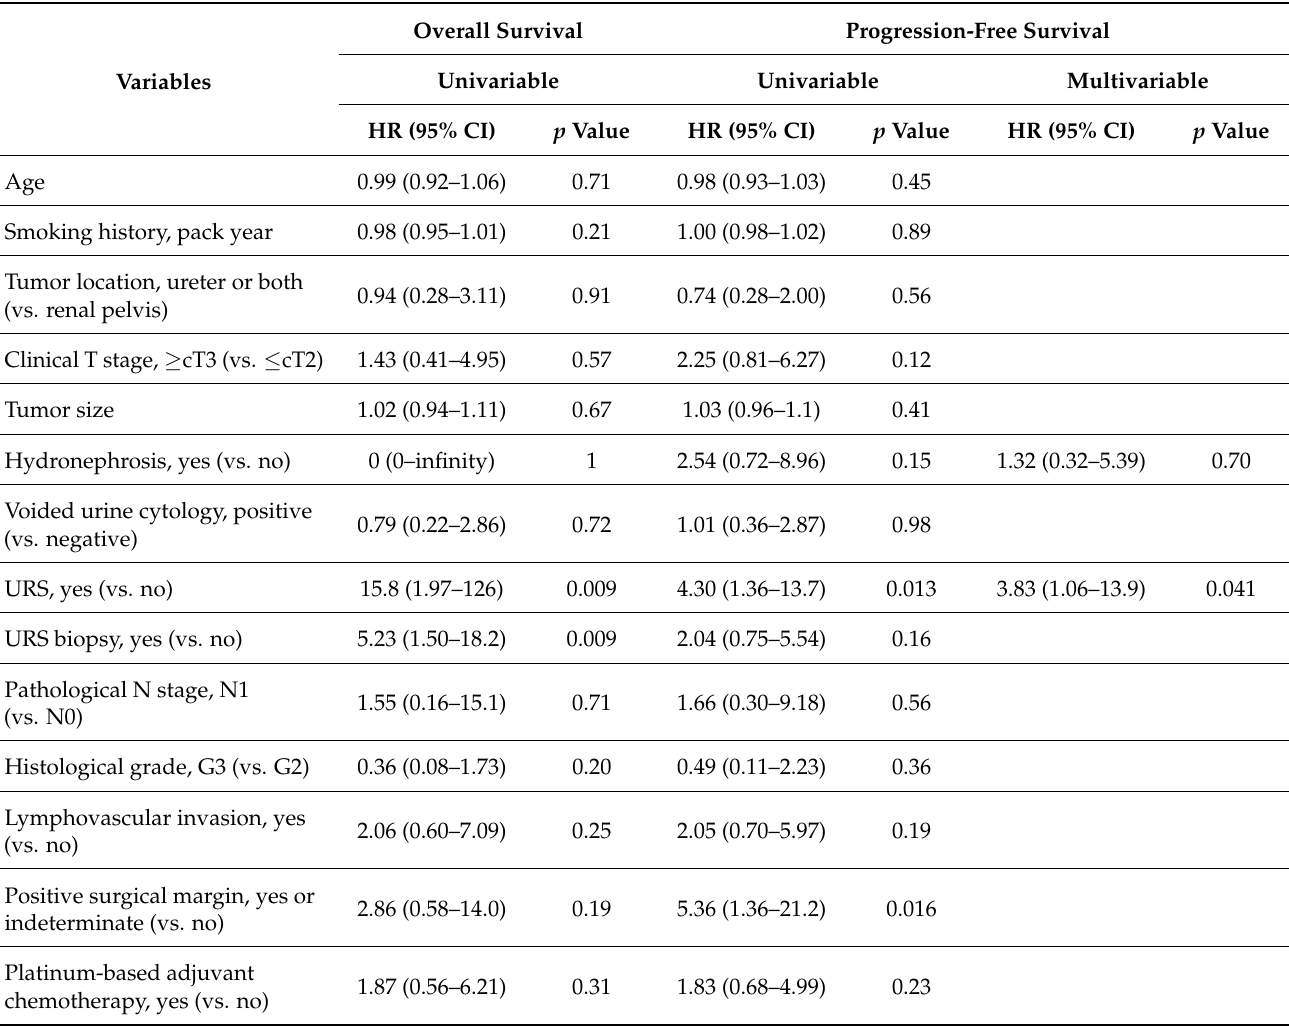
Table 5. Variables associated with overall and progression-free survival in the subgroup of non- papillary architecture and ≥ pT3 (n =